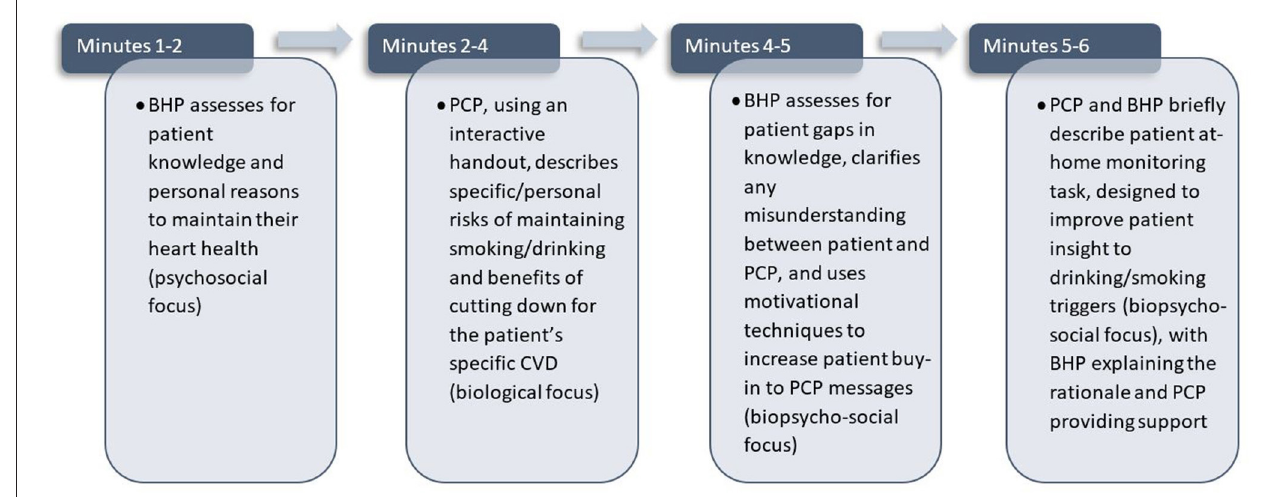
FIGURE 1 | Minute-by-minute description of activities conducted during the 6-min encounter when delivering